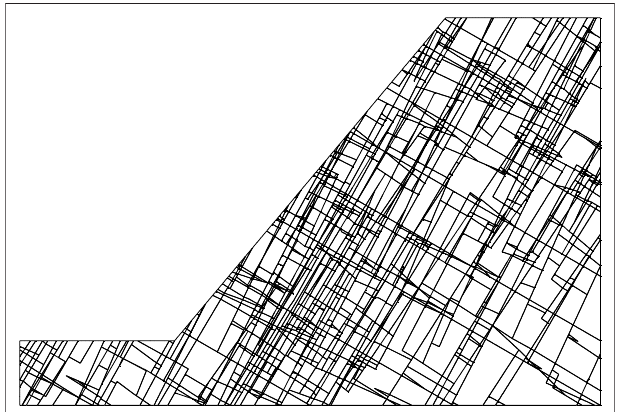
FIGURE 2 | Random fracture network model of the slope on the + 144-m